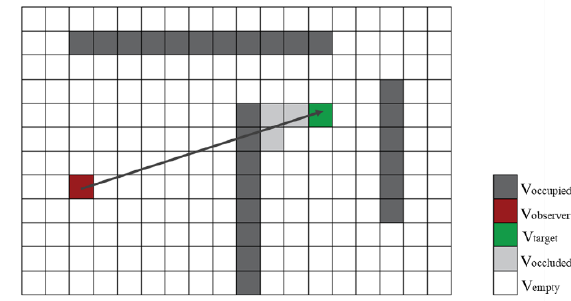
Figure 3. The principle of the ray-tracing algorithm. ‘Occupied’ voxels are represented in dark grey, the ‘observer’ voxel in red, the ‘target’ voxel in green, the ‘occluded’ voxels in light grey and ‘empty’ voxels in white.